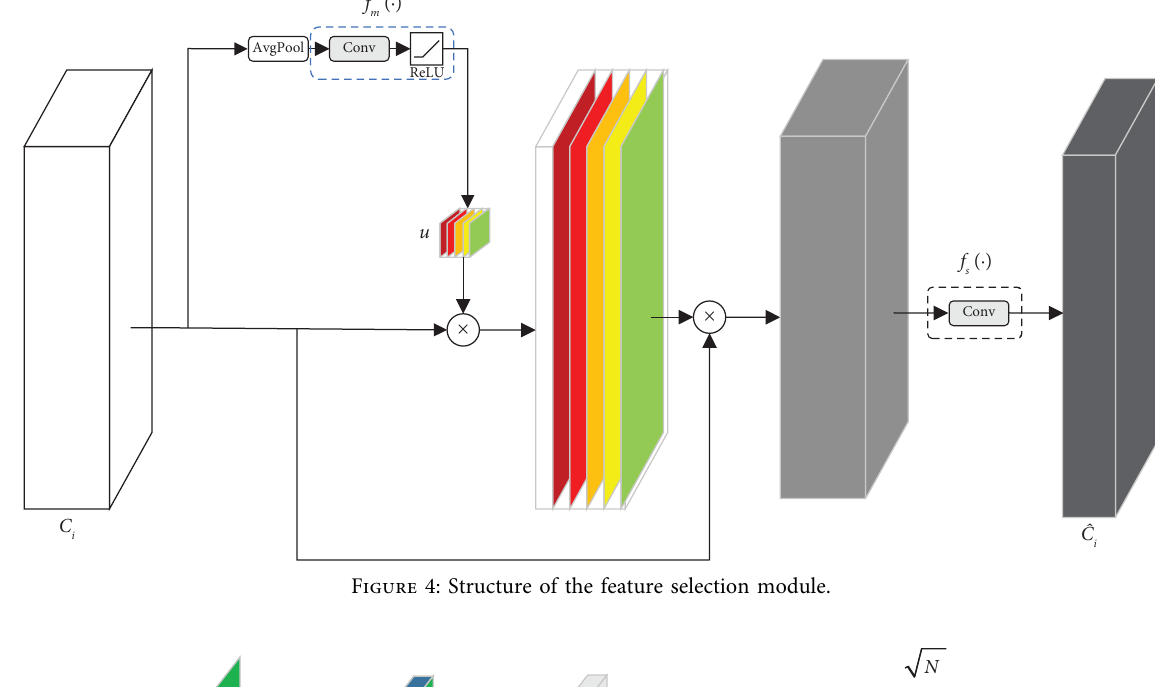
Figure 4: Structure of the feature selection module.